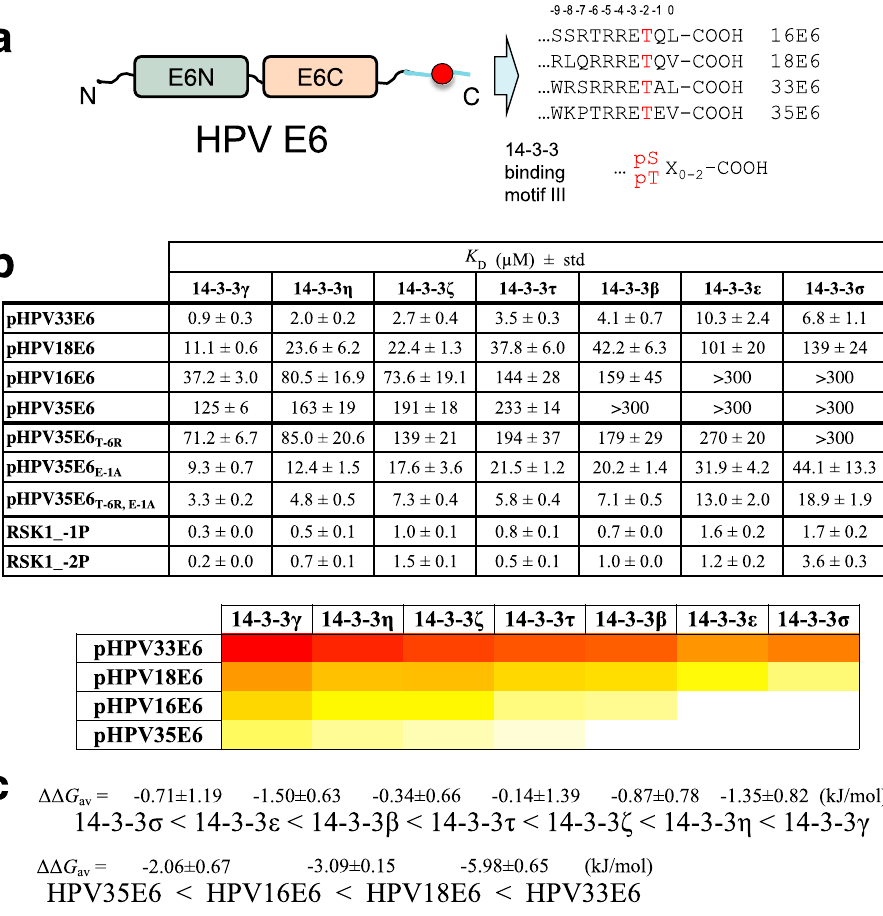
Fig. 1 E6 PBMs reveal parallel binding pro fi les to human 14-3-3 isoforms. a Exemplary phosphorylatable C-terminal E6 PBMs from high-risk mucosal HPV types contain the 14-3-3-binding motif III 9 . The domains of the E6 protein are shown by green (E6N) and beige (E6C) colors, the C-terminal tail containing the phosphorylatable residue (red circle) is cyan. The positions are numbered above the sequences, according to conventional PBM numbering, with the phosphorylatable antepenultimate residue (position – 2) indicated by red. b Af fi nities of four selected HPV E6 phospho-PBMs, p35E6 mutant variants, and RSK1 phosphopeptides toward the seven human 14-3-3 isoforms as determined by fl uorescence polarization using FITC-labeled HSPB6 phosphopeptide as a tracer. Apparent K D values determined from competitive FP experiments are presented. The heatmap representation of the data on b shows the af fi nity trends in the interaction pro fi les between 14-3-3 isoforms and four HPV E6 phospho-PBMs from strongest (red) to weakest (white). Protein names are boldfaced for clarity. c Averaged ΔΔ G values between 14-3-3 isoforms and E6 phospho-PBM pairs, calculated based on their observed order of binding af fi nities (from weakest to strongest). Individual K D values from Supplementary Fig. 2 were fi rst converted into Δ G values (at T = 295K; excluding cases when K D >300 μ M), then average ΔΔ G values ( ΔΔ G av ) were calculated between the indicated motifs/isoforms. Standard deviation (std) values are indicated at each number on b and c (each time, three independent measurements). All binding data are provided as Supplementary Data